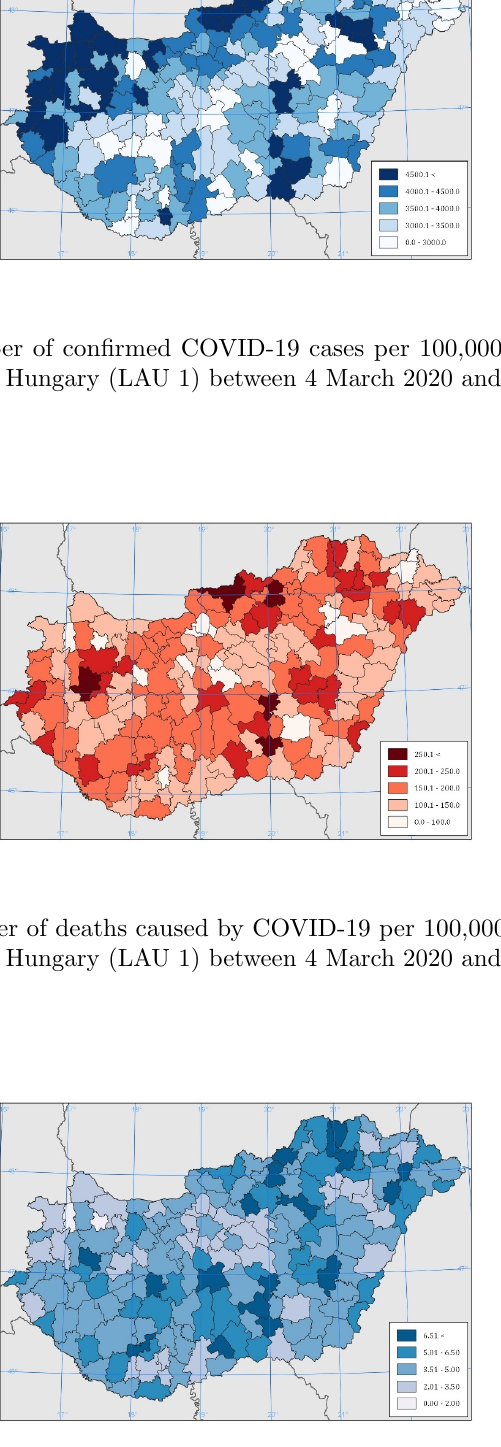
REGION : Volume 8, Number 2,